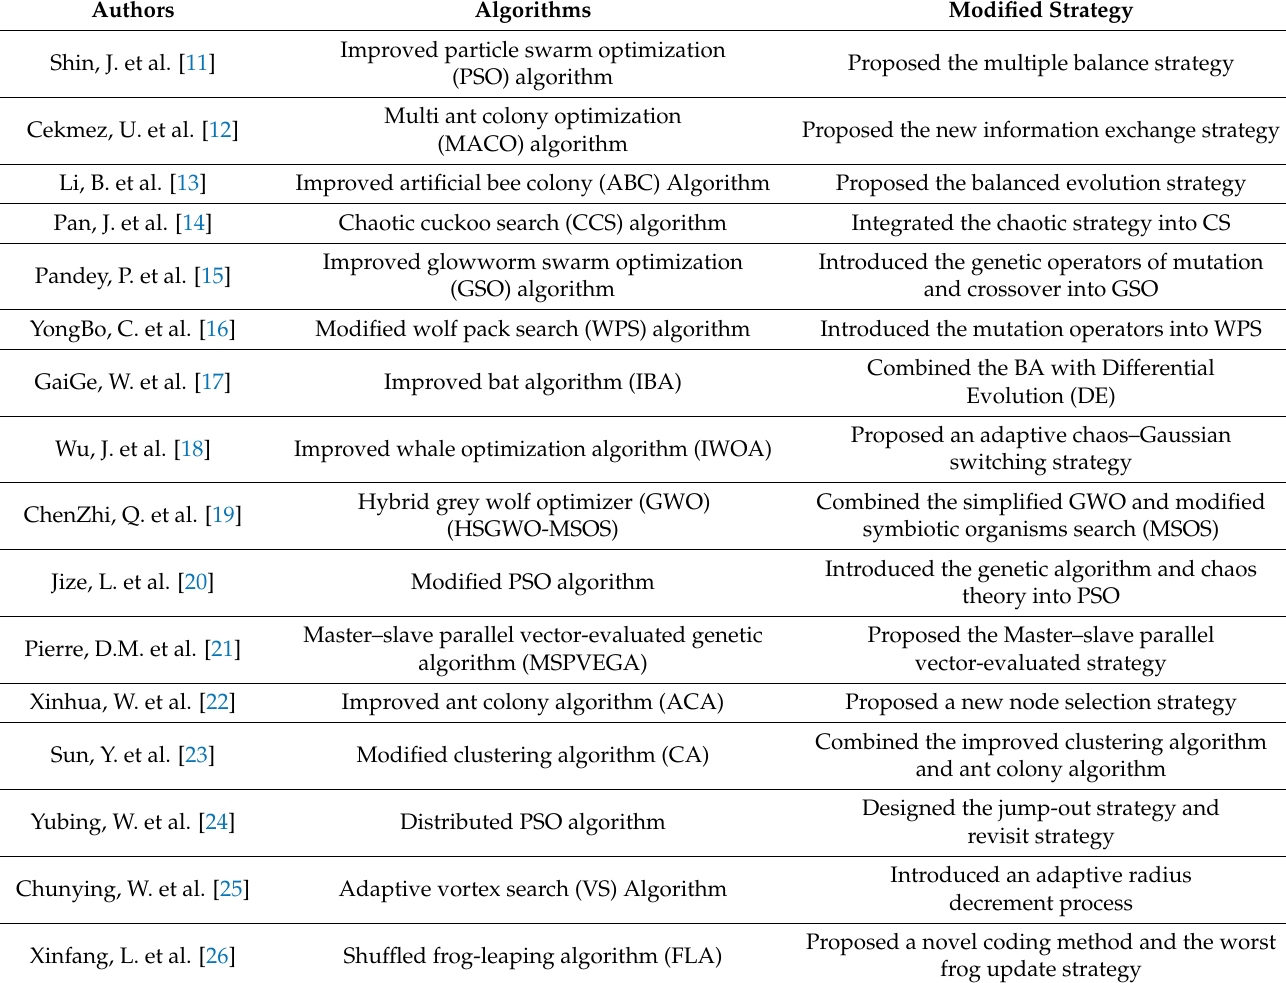
Table 1. Heuristic algorithms for UAV route